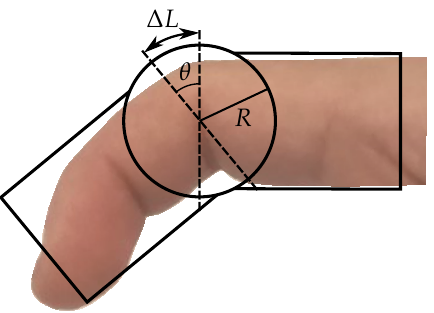
Figure 3. Increase in length ∆ L of the skin over the finger joint due to flexion. Depending on the radius of the joint R and deflection angle θ .